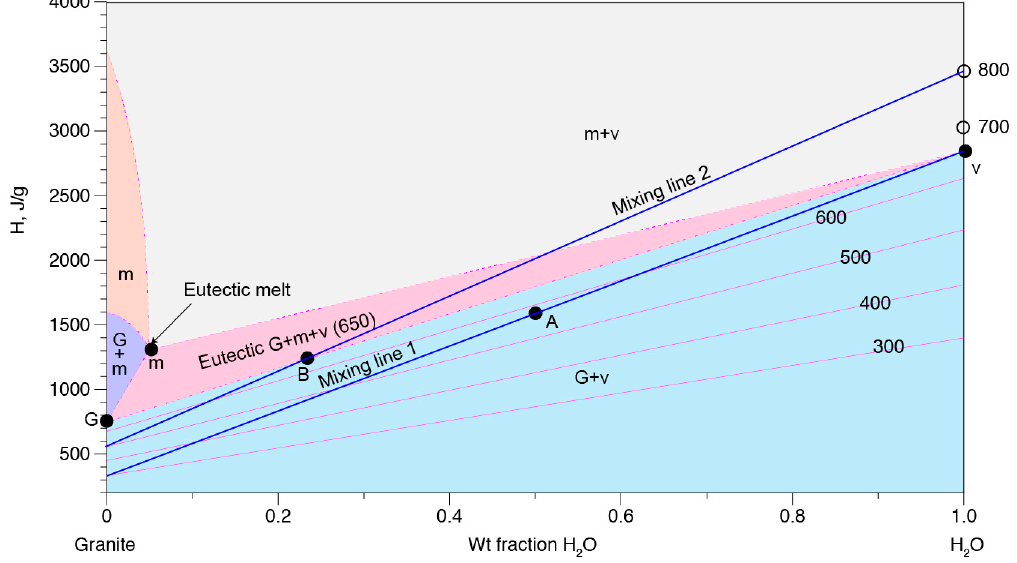
Figure 6. Schematic enthalpy-composition ( H-X ) diagram for the system haplogranite–H 2 O. H 2 O has a much higher specific enthalpy than minerals, and so it carries a significant amount of heat (see text). At and below the eutectic triangle, the diagram is based on thermodynamic data, but phase boundaries on the left side are just schematic. Diagonal magenta lines are isotherms. For clarity, isotherms are not shown above the eutectic. The open circles on the right-hand vertical axis locate the enthalpy of pure H 2 O at 700 ◦ and 800 ◦ C; the corresponding isotherms extend from the open circles in orientations subparallel to the lower-temperature isotherms. Blue lines are mixing lines between H 2 O and the solid quartz–feldspar assemblage. Note that the 800 ◦ C mixing line crosses the solidus (i.e., a water-rock ratio > ca. 0.33 at this temperature) will cause remelting.